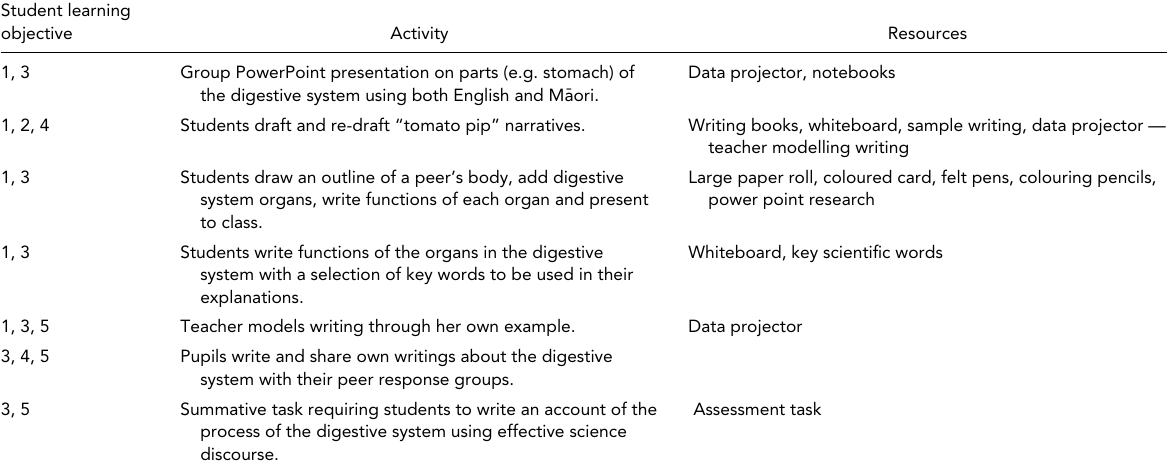
Linking Learning Objectives with Activities and Resources Student learning objective Activity Resources